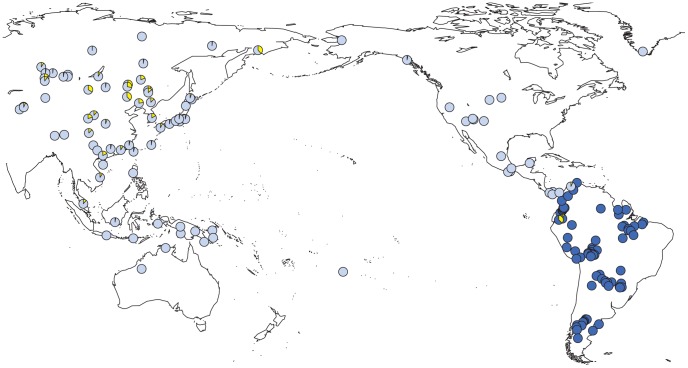
Prevalence of Y-SNP haplogroup C-M217 (C3*) around the Pacific Ocean.Light blue: previous studies; dark blue: present study; yellow: relative frequency of C-M217 (C3*) carriers.